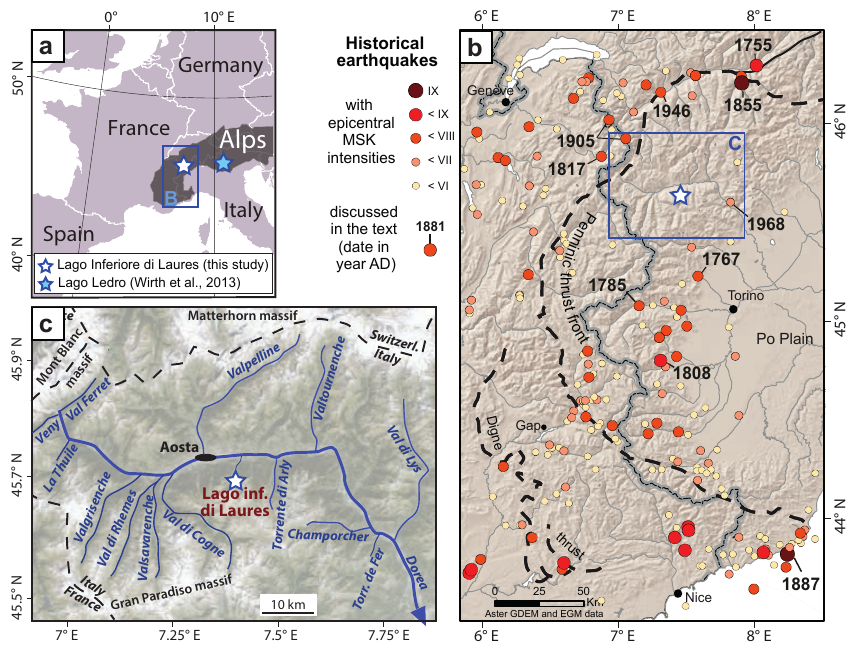
Figure 1. (a) Location of Lago Inferiore de Laures in the Mediterranean Italian Alps, with (b) locations of historical earthquakes with epicentral MSK intensity above IV. The earthquake catalog is provided by the database SisFrance (http://infoterre.brgm.fr/; Lambert and Levret-Albaret, 1996; Scotti et al., 2004). (c) Location of Lago Inferiore de Laures catchment area in the hydrological network of Vallee d’Aosta that is regularly affected by floods as documented by Mercalli et al.